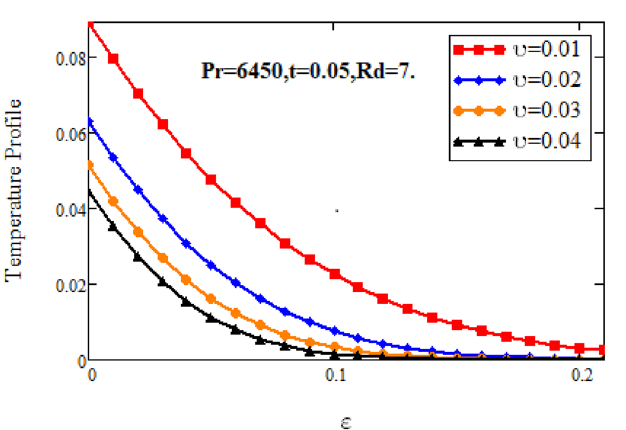
Figure 10. Temperature profiles for various values of ϑ .